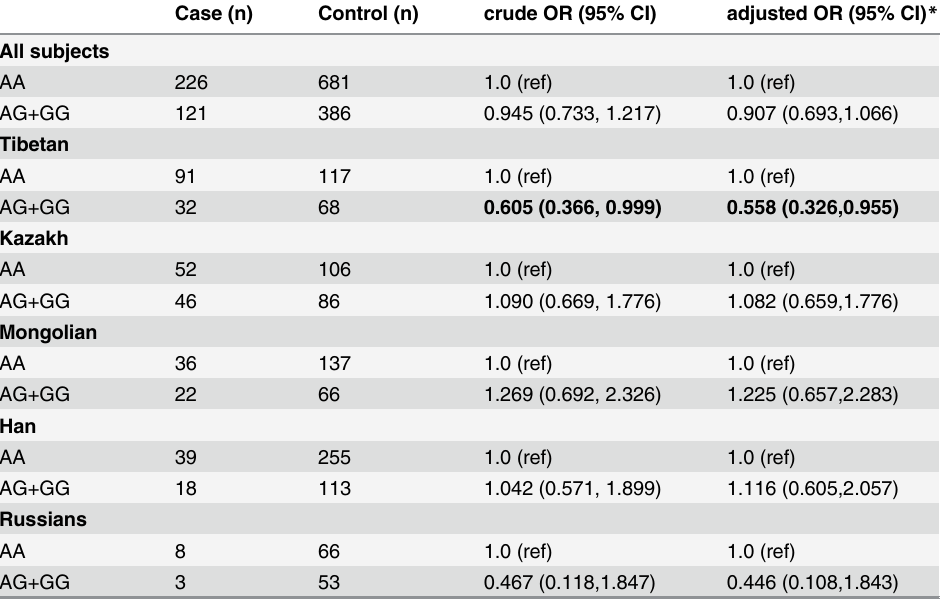
Table 4. Risk of skeletal fluorosis associated with GSTP1 Rs1695 in subjects overall and stratified by ethnicity. Case